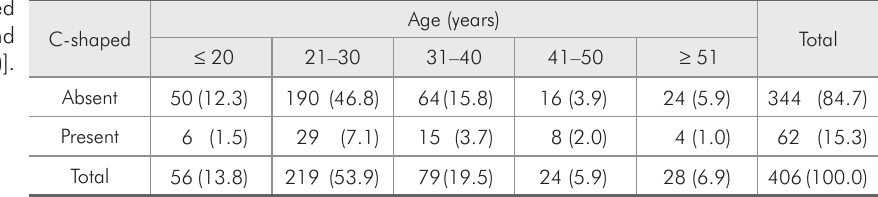
Table 2 - Frequency of C-shaped canals in mandibular second molars by age [n ( % )].